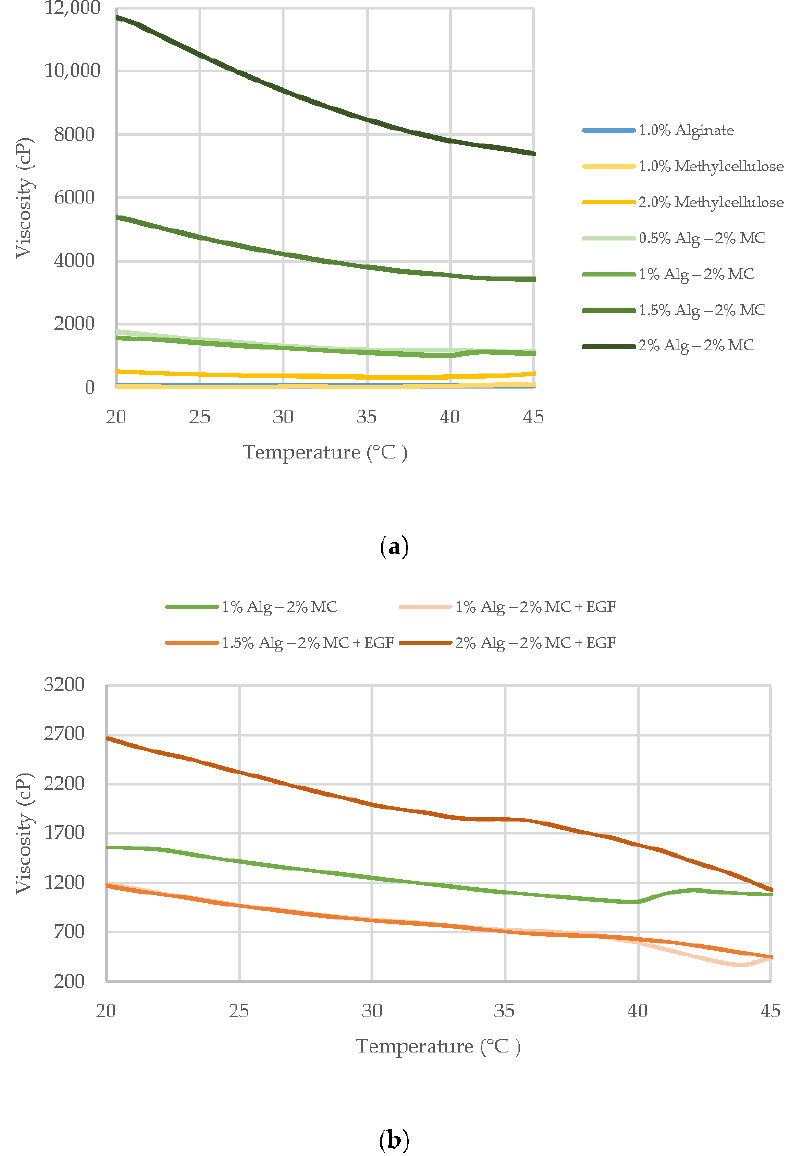
Figure 8. The response of gel systems with varying alginate concentration ( w/v ) as temperature increased by 1 ◦ C per minute: ( a ) Alginate (blue), methylcellulose (yellow), and the resulting mixtures of the two (green); ( b ) The impact of 3.33 mg/mL epidermal growth factor addition (red) on alginate- methylcellulose mixtures (green). Viscosity values were continuously acquired as a function of increasing